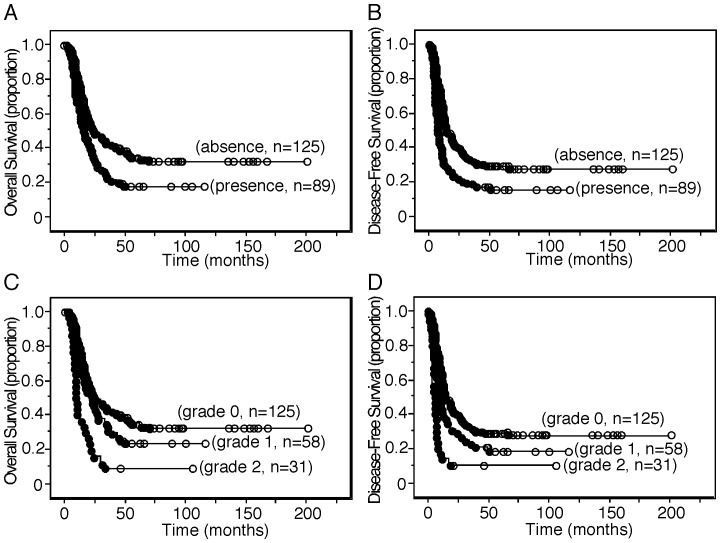
Kaplan-Meier survival curves.(A, C) Kaplan-Meier survival curve showing a comparison of overall survival between the presence (grades 1 and 2) and absence (grade 0) of ARG2 expression in stromal cells (P  = 0.003) in A and that among expression grades (grades 0 to 2) of ARG2 in stromal cells (grade 0 vs. grade 1, log-rank test, P  = 2.08; grade 0 vs. grade 2, P<0.0001; grade 1 vs. grade 2, P  = 0.0009) in C. (B, D) Kaplan-Meier survival curve showing a comparison of disease-free survival between the presence (grades 1 and 2) and absence (grade 0) of ARG2 expression in stromal cells (P  = 0.0006) in B and that among expression grades (grades 0 to 2) of ARG2 in stromal cells (grade 0 vs. grade 1, P  = 0.069; grade 0 vs. grade 2, P<0.0001; grade 1 vs. grade 2, P  = 0.013) in D. Black circle and white circle represent censoring and failure, respectively.